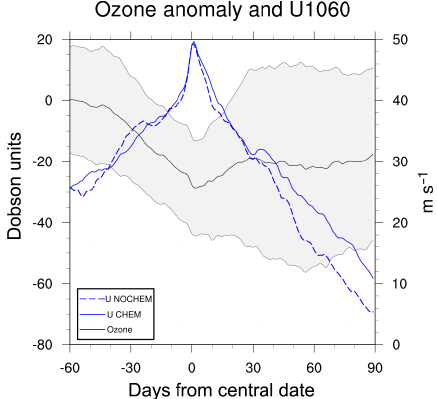
Figure 11. As in Fig. 7 but for DJF